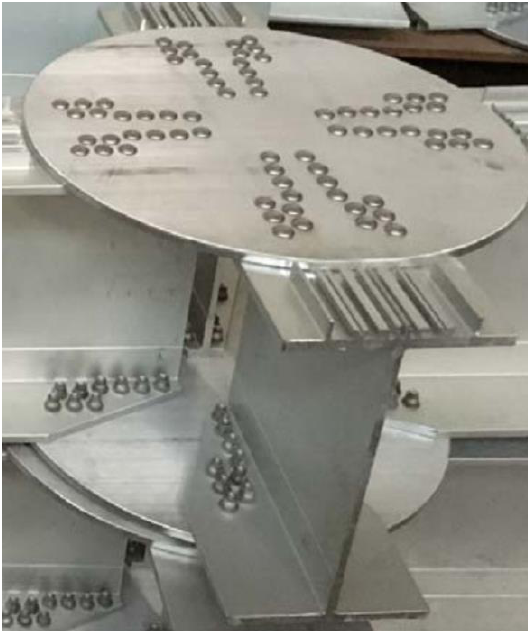
Figure 1. Photograph of aluminum alloy gusset joint.